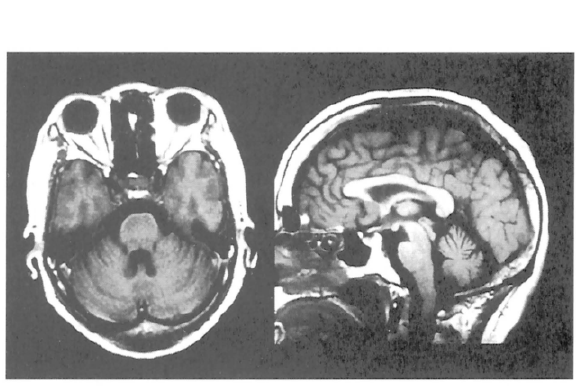
FIG. 1. MRI (Tl-weighted image) revealed marked atrophy in both cerebellar hemispheres and vermis, and slight atrophy in the brainstem.